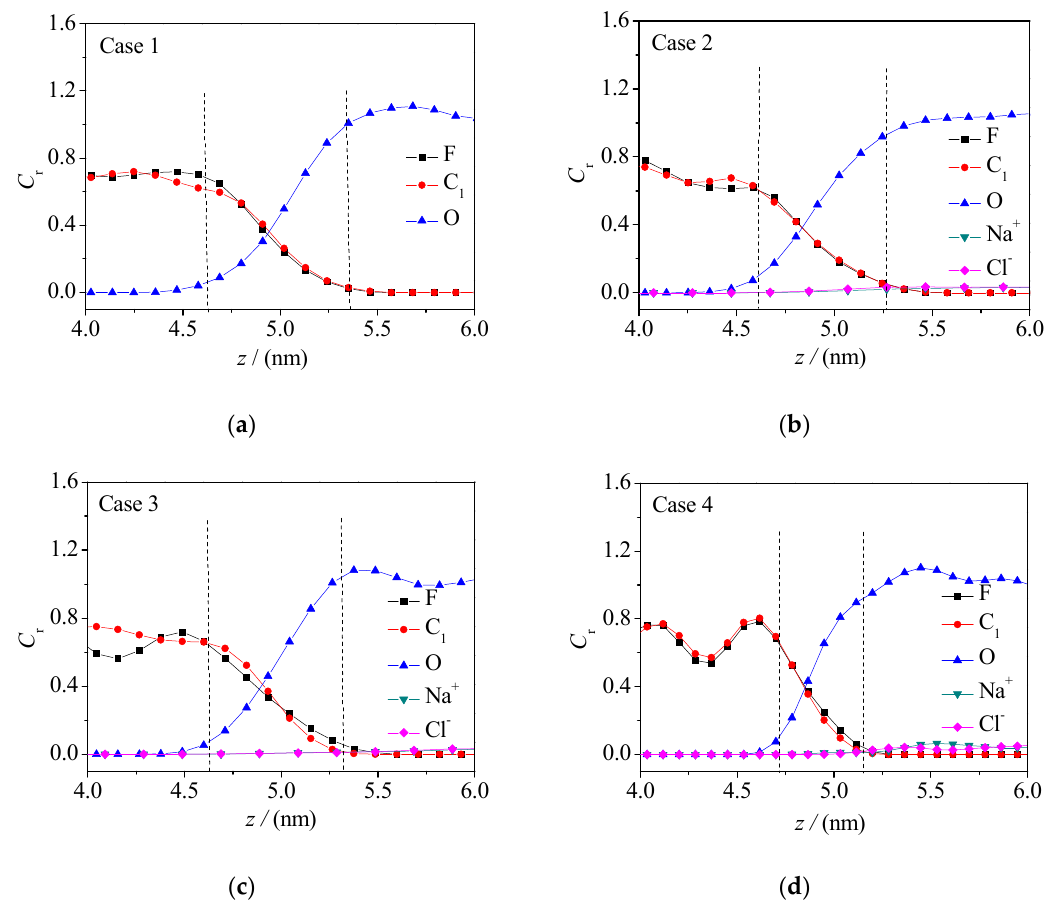
Figure 4. Concentration distribution curve of F, C, O, Na + , and Cl − at the oil–water interface in the fluorobenzene–NaCl aqueous solution system: ( a ) Case 1; ( b ) Case 2; ( c ) Case 3; ( d ) Case 4.